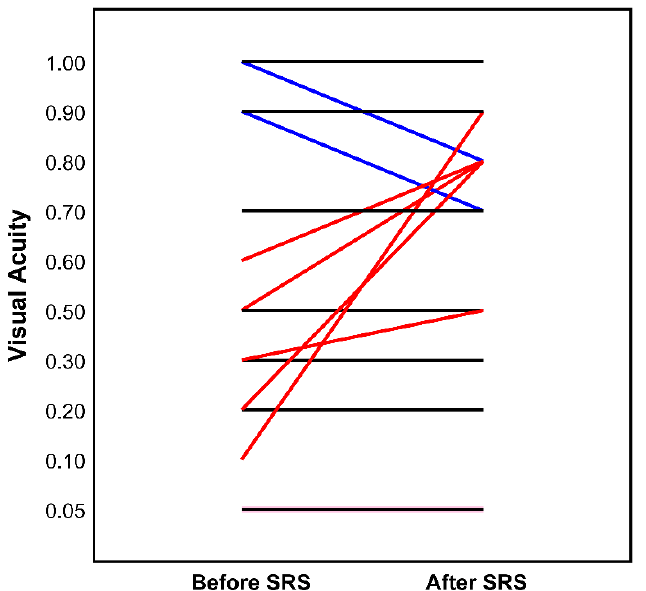
Figure 4. Visual acuity (decimal) before and after (latest available follow-up) Cyberknife ( n = 16, excluded: WHO > 4). Each line represents one patient: black—idem, red—improved, blue—impaired visual acuity.